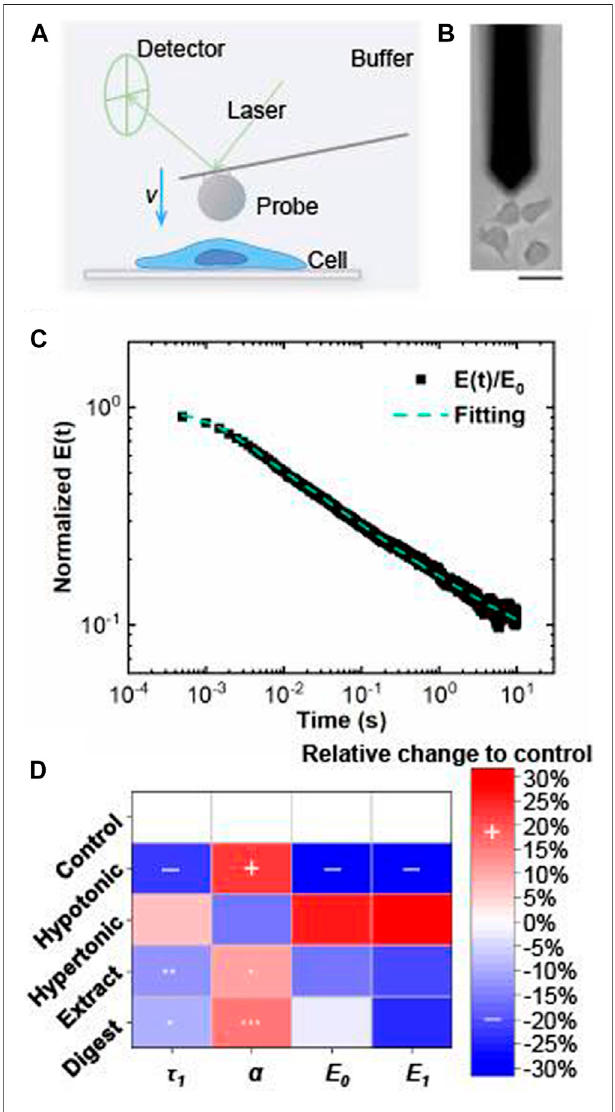
FIGURE 11 | Viscoelastic properties of EBN-treated keratinocyte evaluated by atomic force microscopy. (A) Atomic force microscopy (AFM) setup for mechanical measurements of single cell (side view). (B) Bright fi eld imageofAFMmeasurement(top view). Bar (cid:2) 35 μ m. (C) Asamplecurve of normalized relaxation modulus E ( t ) / E 0 as the function of time. Green dash lineis fi ttingtothemeasuredrelaxationdata,showingashort-timeexponential decay followed by a long-time power-law decay. (D) Relative changes of E 0 , E 1 , τ 1 , and α to the control group under different treatments in cultured keratinocyte, as in Figure 2 . Simultaneous decrease of E 0 , E 1 , τ 1 , and increase of α show the moisturization of cells; while increase of E 0 , E 1 , τ 1 , and decreaseof α showthedehydrationofcells.Theparametermapindicatesthat EBN-treated keratinocyte (100 μ g/mL extract n (cid:2) 30, 100 μ g/mL digest n (cid:2) 31) becomes moisturized, similar to cells under hypotonic condition (227 mOsm/kg, n (cid:2) 6) and opposite to hypertonic one (366 mOsm/kg, n (cid:2) 10). Statistically signi fi cant results are marked with * p < 0.05, ** p < 0.01, and *** p < 0.001 against the